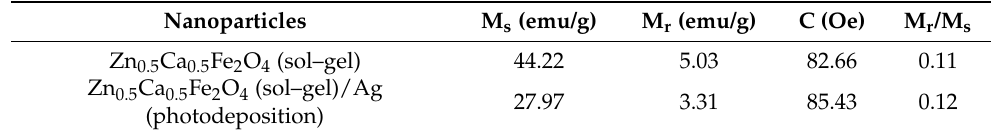
Table 2. Coercive field (C), saturation magnetization (M s ), remanent magnetization (M r ), and ratio M r /M s for zinc/calcium ferrites at room temperature.